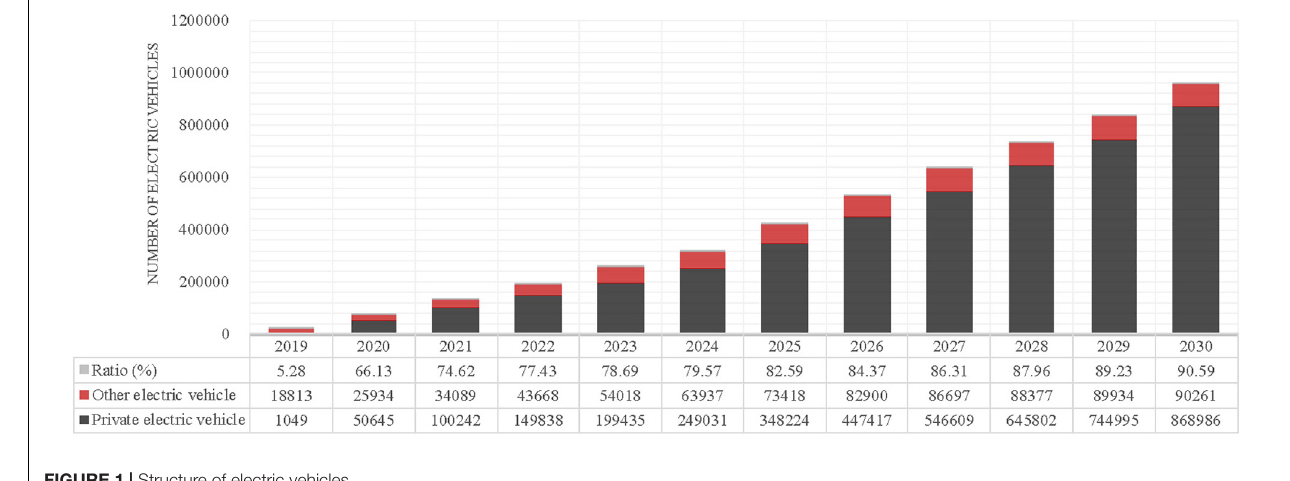
FIGURE 1 | Structure of electric vehicles.